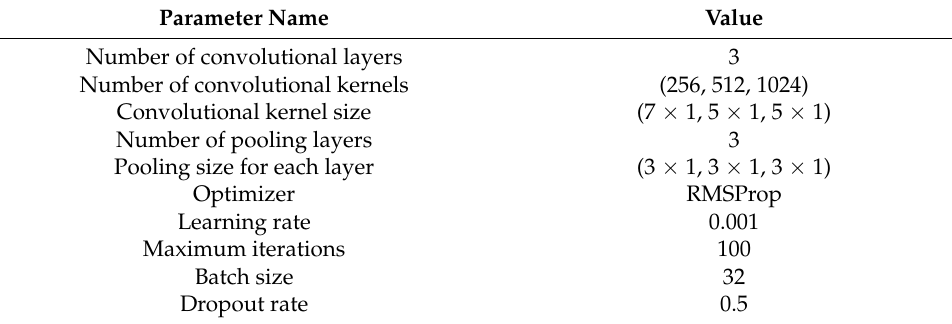
Table 3. The 1D-CNN parameter